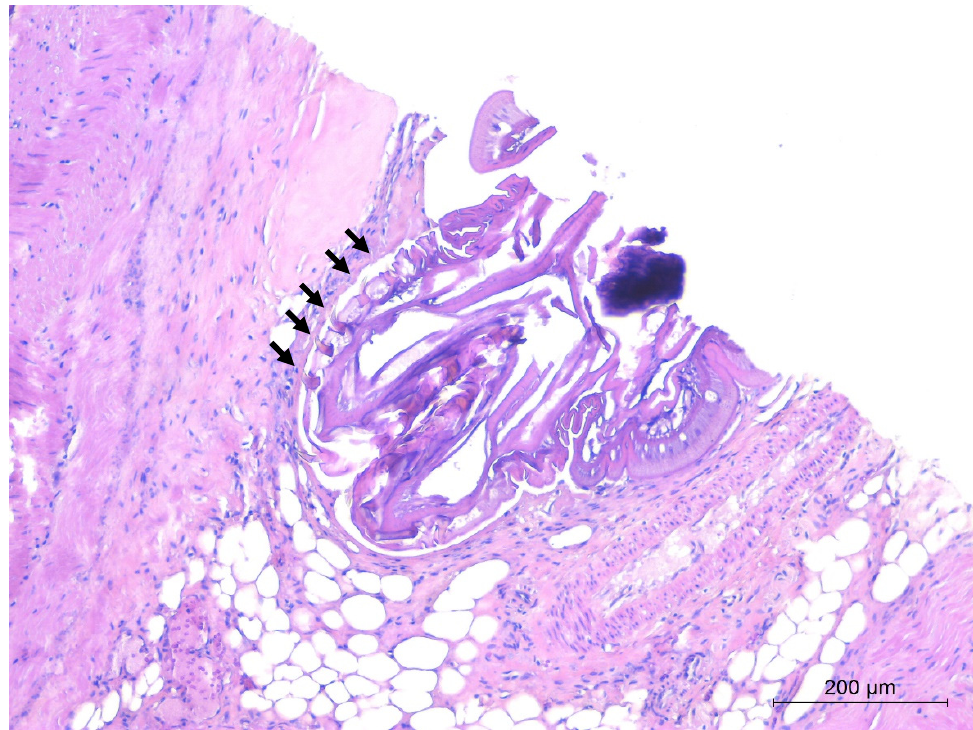
Figure 5. European hedgehog, intestine. Section of proboscis with spines (arrows) of an adult Acanthocephalan parasite, embedded in the intestinal mucosa. Hematoxylin and Eosin (HE).